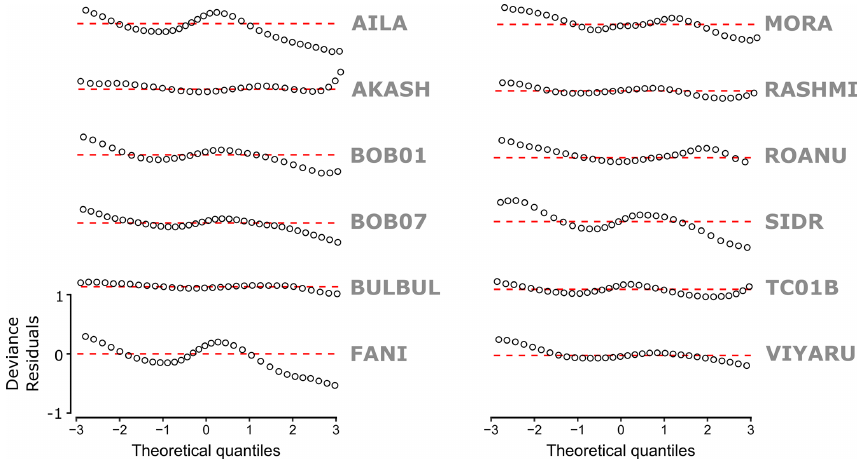
Figure 2. Detrended quantile–quantile (worm) plots for each GAM model per storm. We discretise the quantiles into 50 bins (open circles). The red dashed line represents zero deviance between data and theoretical quantiles defined in the GAM. Where model quantiles deviate below (above) the zero deviance line, this implies that the model predictions are overestimated (underestimated) relative to the data: for any given theoretical model quantile, the data quantile is lower (higher). Deviance residuals respect the model family used when fitting the GAM and are calculated via the simulation method of Augustin et al. (2012).